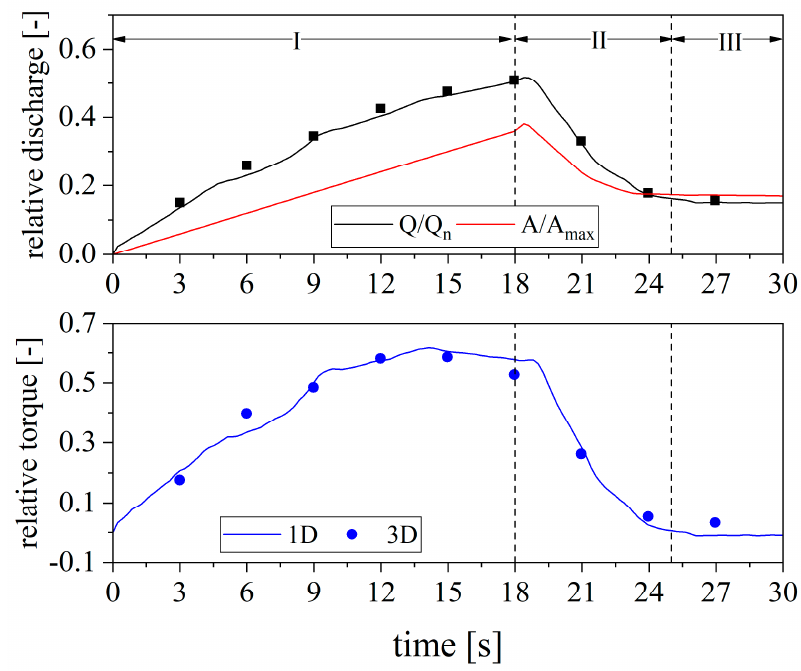
Figure 8. The variation of torque and discharge during start-up process.